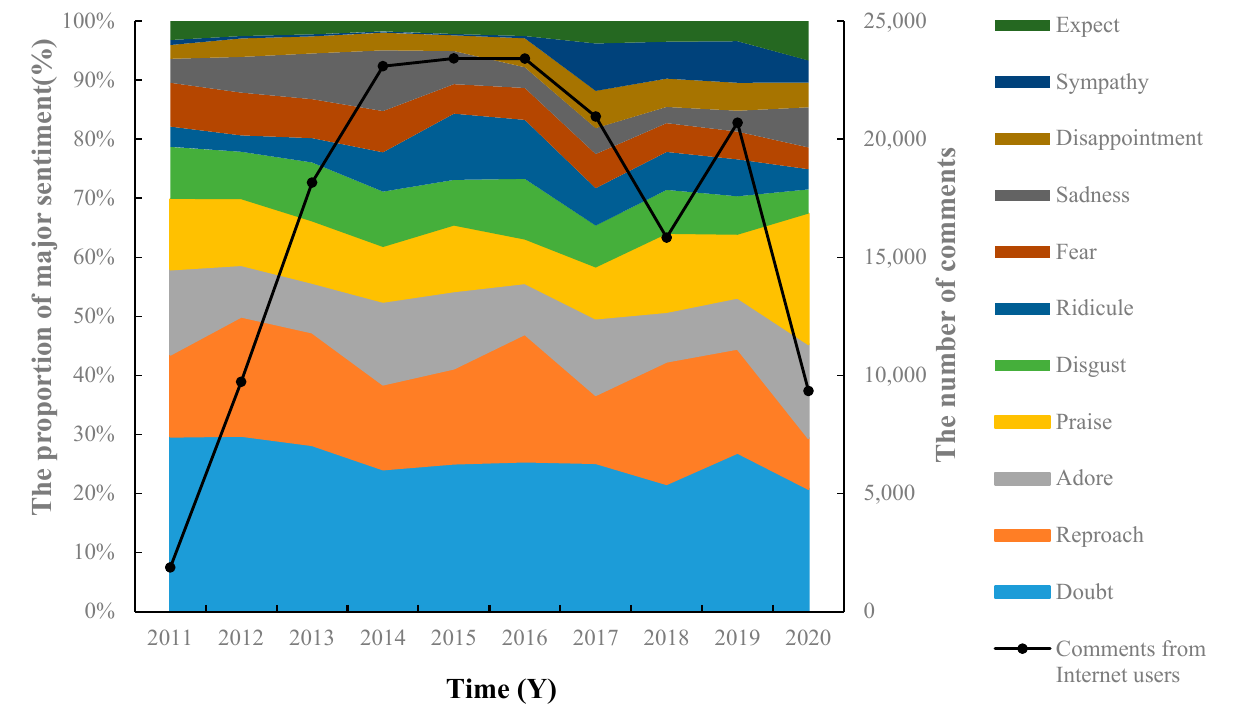
Figure 4. Trend of consumer’s emotion about additive issues from 2011 to 2020.